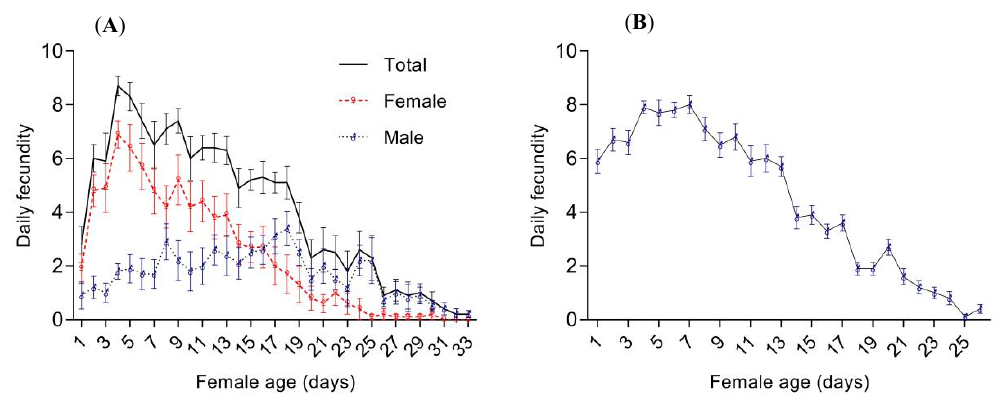
Figure 3. The daily fecundity of T. drosophilae females with ( A ) or without ( B ) males. Data are mean ± SE. Trichopria drosophilae females which mated with males lived significantly longer when host-deprived. Under host-provided conditions, T. drosophilae females without copulation lived significantly longer than those which mated with males ( χ 2 = 10.89, df = 2, p < 0.05; Figure 5). The longevity of mated and 52.00 ± 2.23 d (N = 20, range: 33–56), respectively, whereas adult females which mated with males